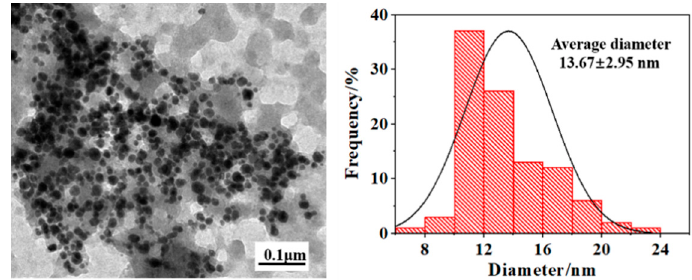
Polymers 2020 , 12 , x FOR PEER REVIEW Figure 3. TEM images and diameter distributions of the as-synthesized AgNPs. Figure 3. TEM images and diameter distributions of the as-synthesized AgNPs.